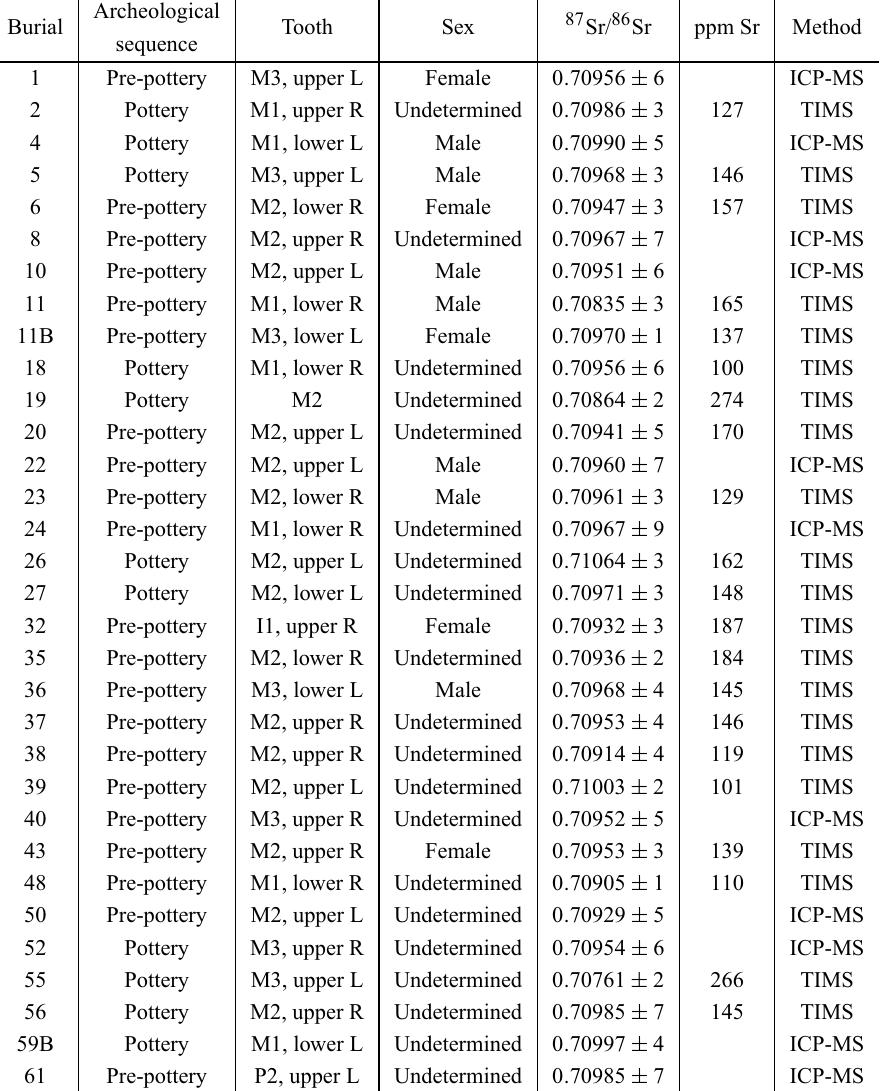
Municipalities with sites belonging to the Itararé Tradition and sambaquis in Cananéia with low strontium isotope ratio. SC – Santa Catarina State; RS – Rio Grande do Sul State; PR – Paraná State; SP – São Paulo State; FML – Forte Marechal Luz